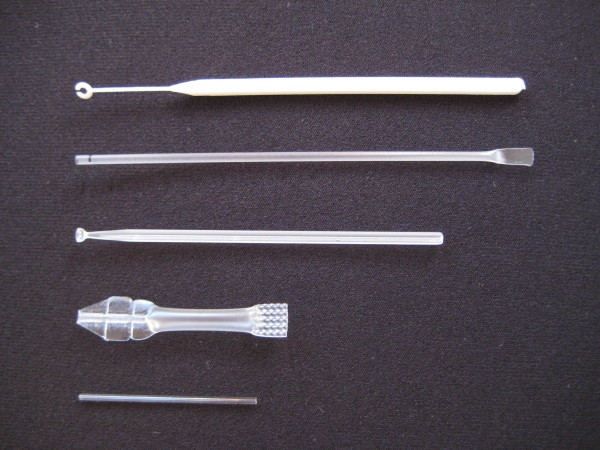
Photograph of blood transfer devices evaluated. From top to bottom, the loop, straw-pipette, inverted cup, calibrated pipette, and glass capillary.